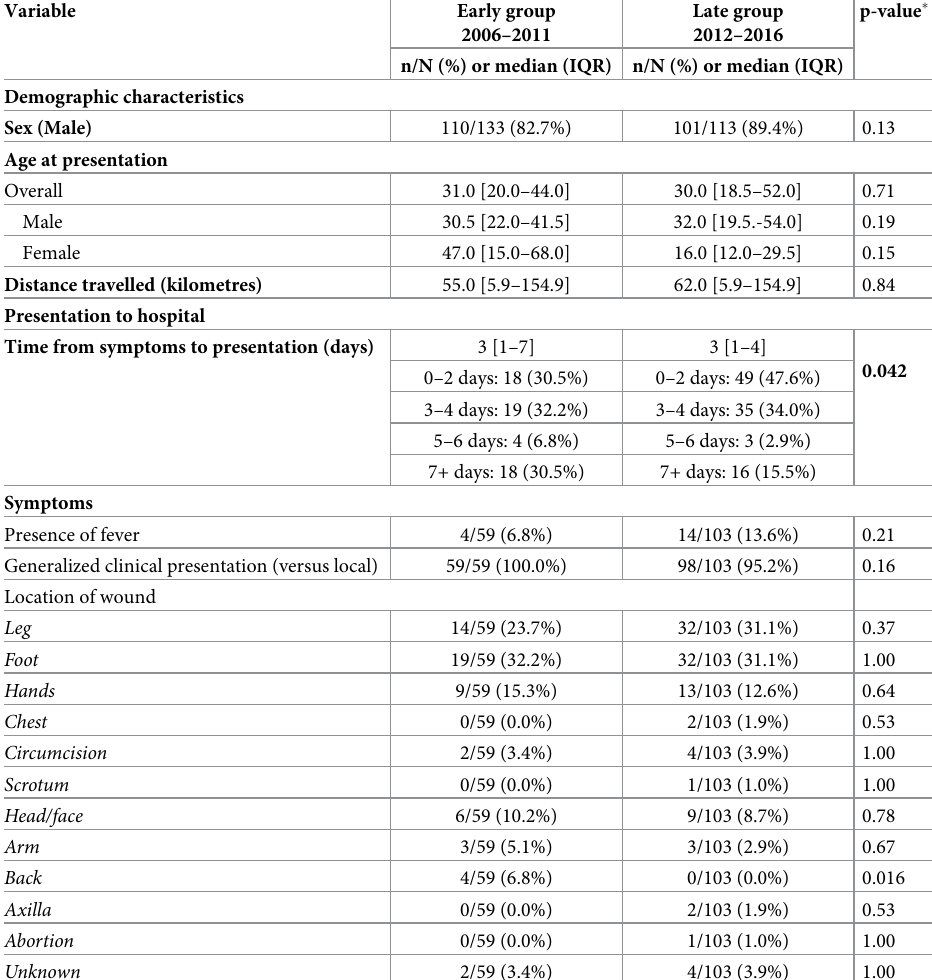
Table 1. Baseline demographic characteristics for the early and late groups. Variable